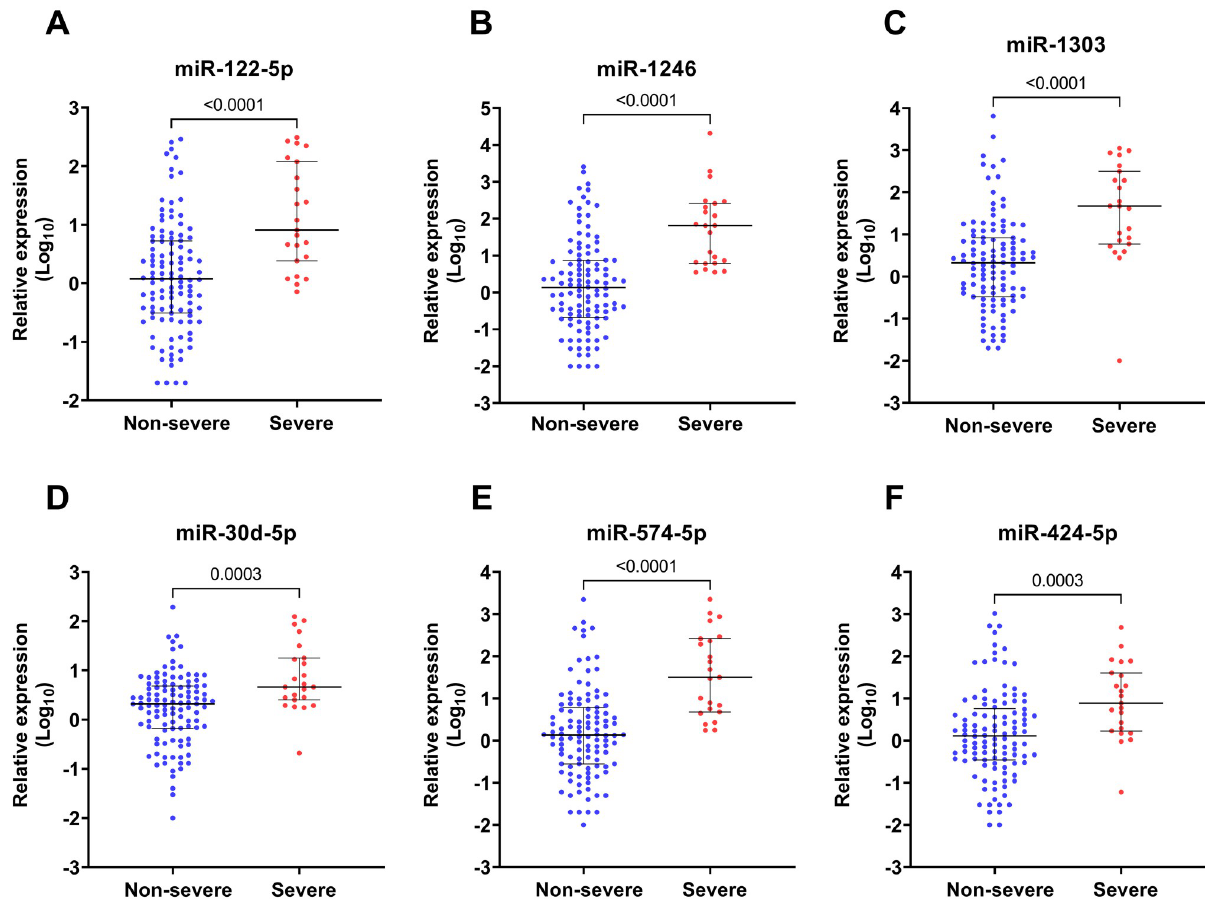
Fig 2. Relative expression of serum miRNAs in patients with severe and non-severe dengue. 1246, miR-1303, miR574-5p, and miR424-5p positively correlated with AST level and miR- 574-5p positively correlated with ALT level. In contrast, we found several miRNAs negatively associated with platelets count, with miR-574-5p showing the strongest correlation, followed by miR-1246, miR-1303, and miR122-5p. Serum miRNAs as biomarkers of severe dengue The ROC curves for six miRNAs were generated to calculate diagnostic accuracy. Six miRNAs could discriminate between the severe dengue and non-severe groups with an AUROC of 0.83 (95%CI;0.76–0.91, p < 0.001) for miR-574-5p, 0.83 (95%CI;0.76–0.90, p < 0.001) for miR-1246, 0.80 (95%CI;0.71–0.90, p < 0.001) for miR-1303, 0.78 (95%CI;0.69–0.87, p < 0.001) for miR- 122-5p, 0.73 (95%CI;0.63–0.84, p < 0.001) for miR-424-5p and 0.73 (95%CI;0.63–0.84, p = 0.001) for miR-30d-5p (Fig 3). In addition, we found that miRNAs are better predictors than other clinical biomarkers like persistent vomiting (AUC = 0.65, 95%CI;0.52–0.78, p = 0.026) and body temperature (AUC = 0.73, 95%CI;0.61–0.85, p = 0.001) as shown in S6 Fig. We also compared the predictive accuracy of serum miRNAs on different disease days (day of defervescence was defined as day 0). The result showed that all six miRNAs distinguished